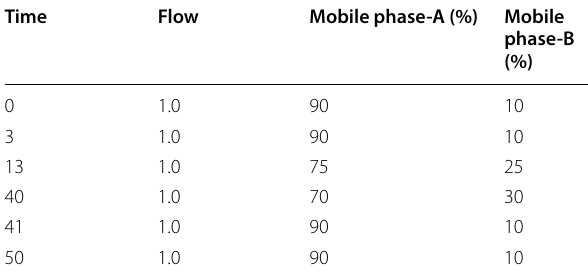
Table 2 Mobile phase program for gradient elution